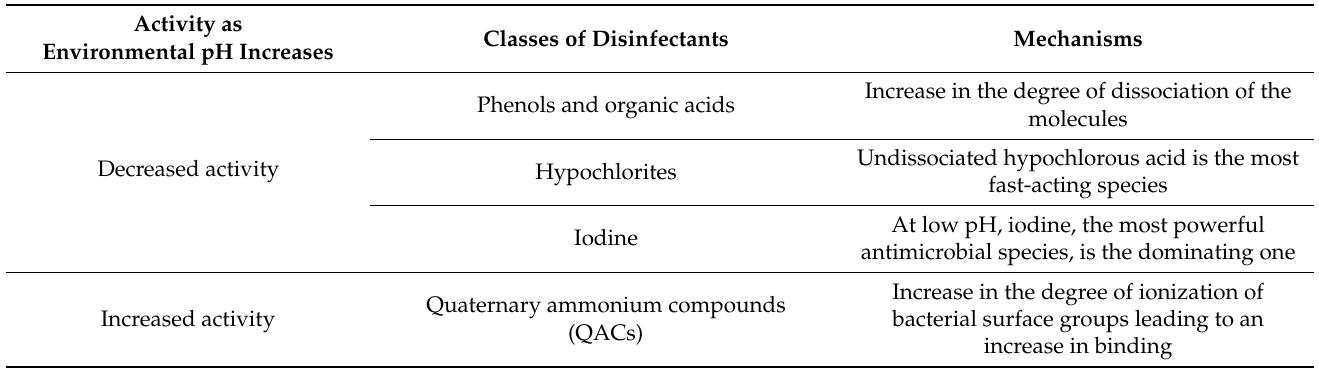
Table 3. Effects of pH level on antimicrobial